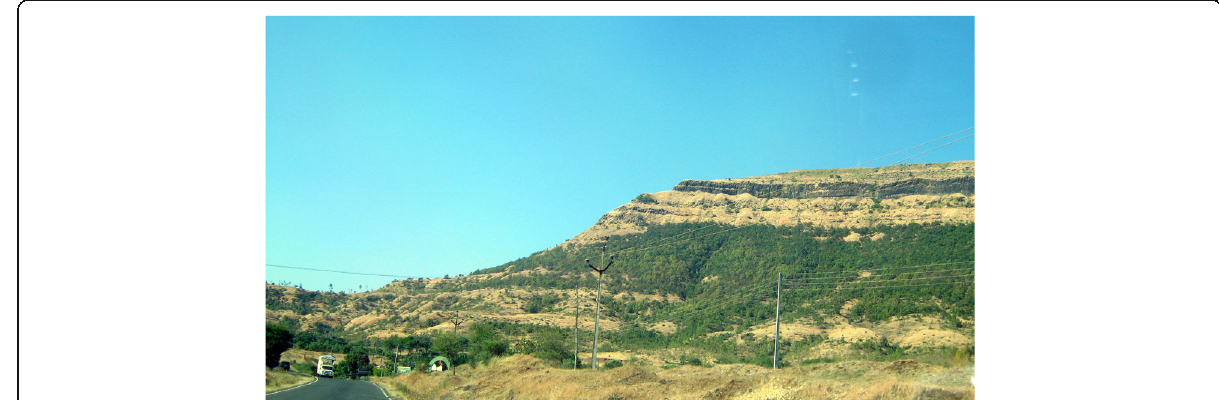
Fig. 2 Field photo showing basalt flow